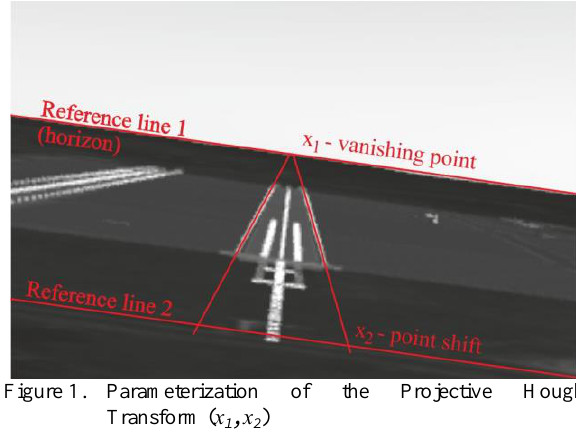
Figure 1. Parameterization of the Projective Hough Transform ( х 1 , х 2 )